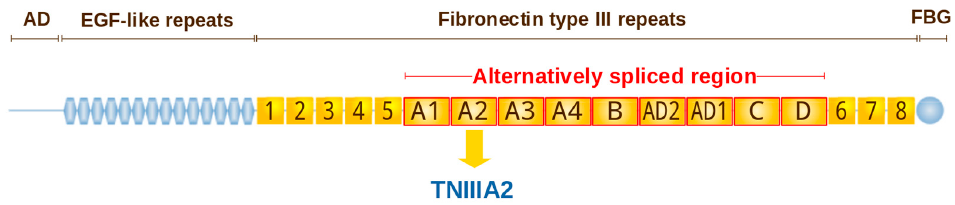
Figure 4. Domain structure of human tenascin-C (based on SMART-tool [176] and review [226]). N-terminal assembly domain (AD) links the tenascin chains and mediates the oligomerization and formation of hexamers. The assembly domain is followed by the EGF-like repeats and two types of FN-III domains: conserved (yellow rectangles) and alternatively spliced (yellow with red), and the C-terminal fibrinogen-like domain (FBG). Tenascin-C-derived 22-mer peptide TNIIIA2.